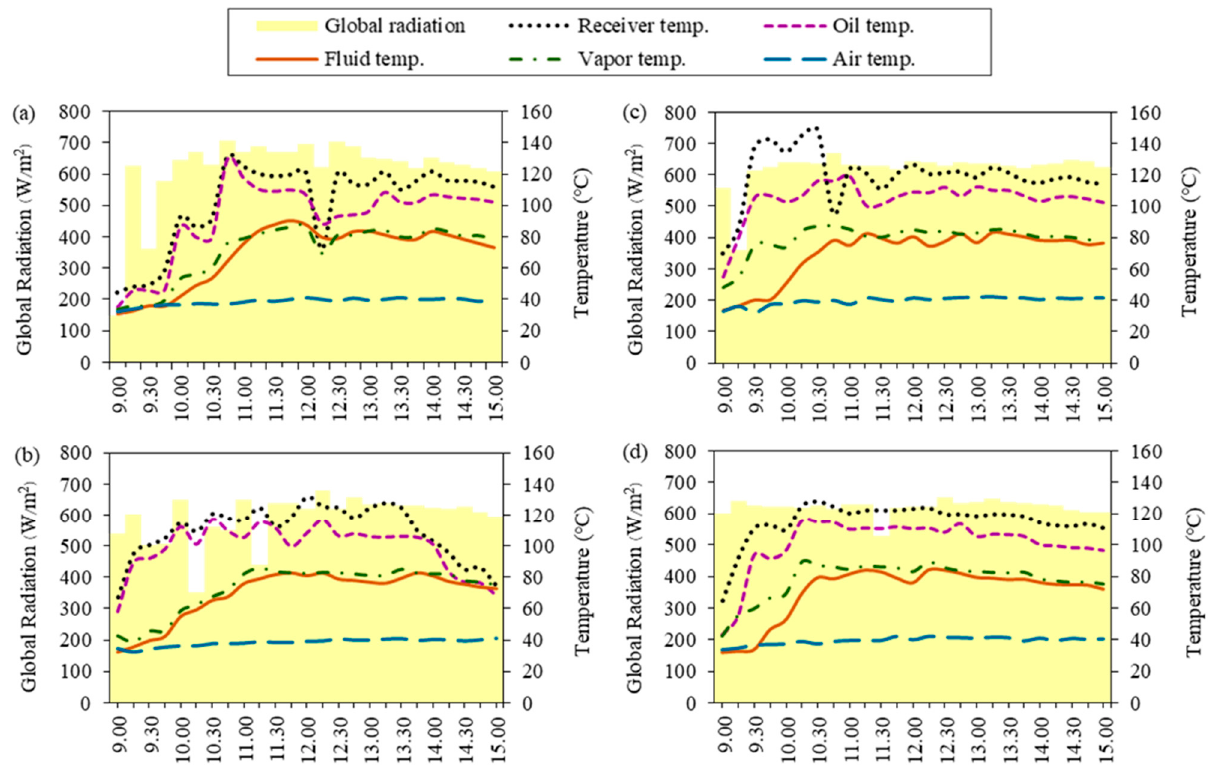
Figure 3. Global radiation and temperature at different solution concentrations: ( a ) 10% initial ethanol concentration, ( b ) 15% initial ethanol concentration, ( c ) 20% initial ethanol concentration, and ( d ) 23% initial Sato concentration.